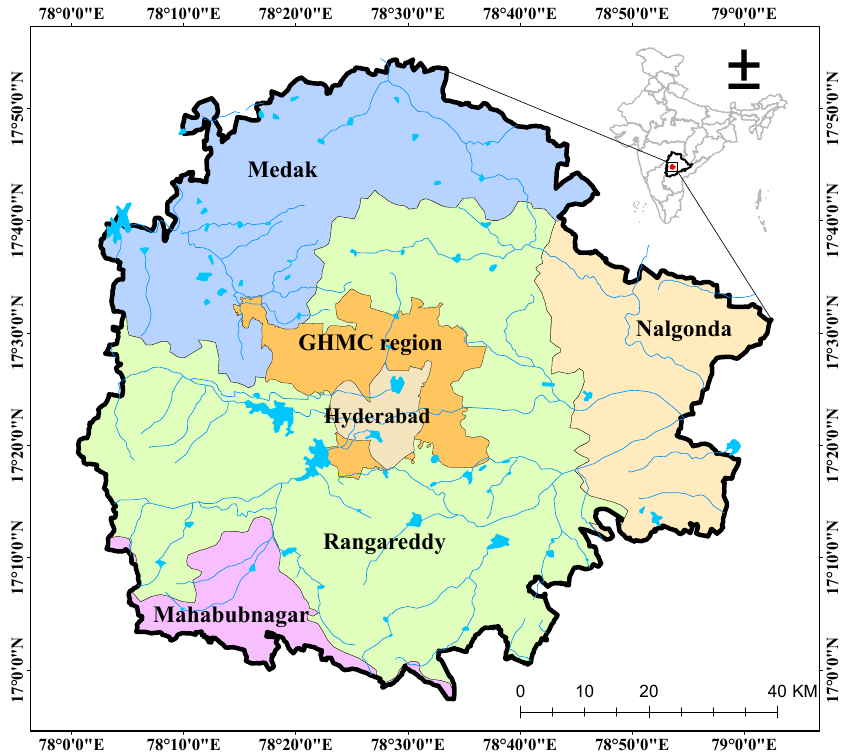
Figure 1. Jurisdictions of Hyderabad Metropolitan Development Authority (HMDA) region show- ing the boundaries of Greater Hyderabad Municipal Corporation (GHMC) and five districts, i.e., Hyderabad, Ranga Reddy, Nalgonda, Medak and Mahabubnagar.